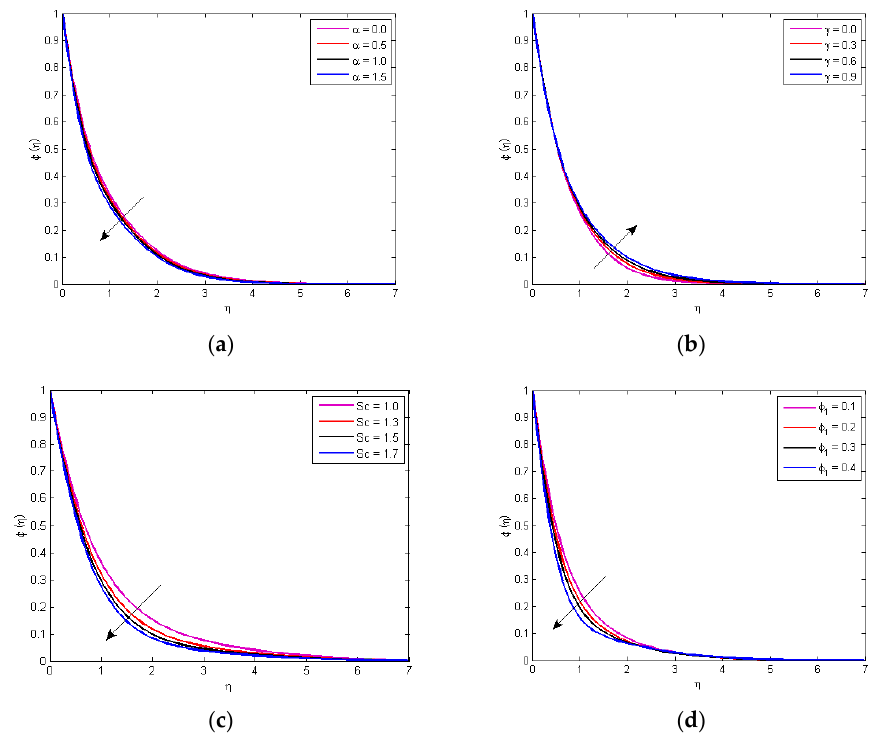
α γ , ( b ) is , ( c ) is Sc , ( d ) is